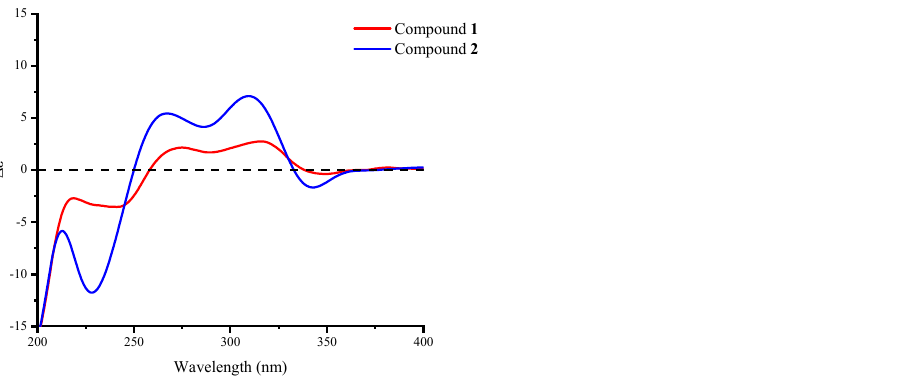
Figure 4. Experimental CD spectra of compounds 1 and 2 .